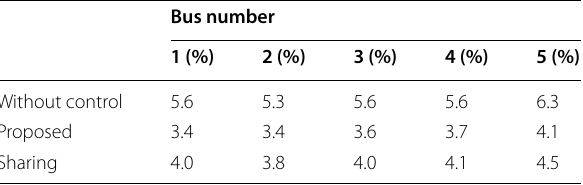
Table 4 The voltage THD of each bus in the simulation